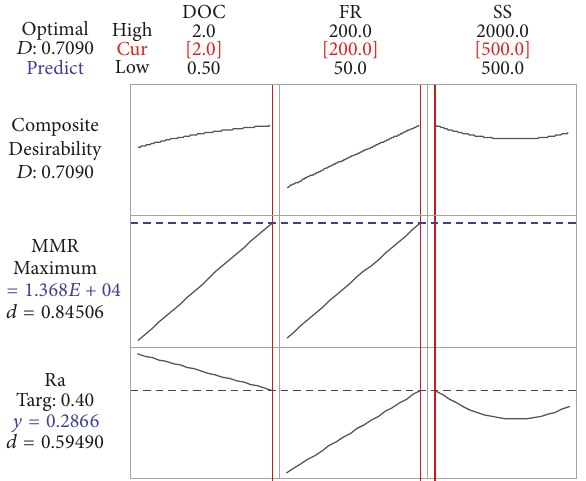
Figure 6: Optimization plot for Ra and MRR.